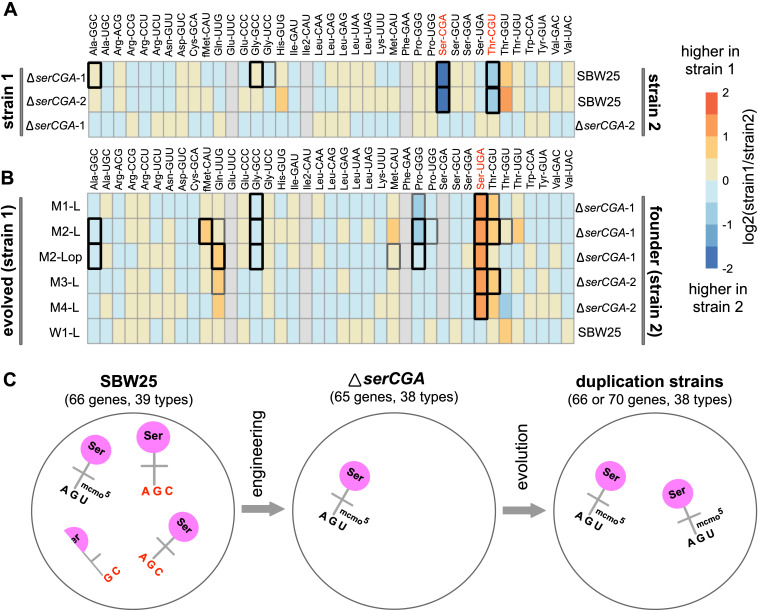
Heatmaps showing differences in mature tRNA levels between strains.The log2-fold.change(strain1/strain2) difference in expression for 36 mature tRNA types (with 38 different primary sequences) was determined for pairs of strains using DESeq2. (A) Mature tRNA expression levels in the serCGA deletion mutants compared with SBW25, demonstrating a consistently lower levels of tRNA-Ser(CGA) and tRNA-Thr(CGU) upon deletion of serCGA. tRNAs in red show a consistent difference in all comparisons except ΔserCGA-1 versus ΔserCGA-2 (row 3), the control comparison for which no significant differences in mature tRNA levels were detected. (B) tRNA-Ser(UGA) is higher in the mature tRNA pool in each of the five serTGA duplication isolates compared with the deletion mutant (with no significant differences detected in the wild type control Line, row 6). Some tRNA types were removed from the DESeq2 analysis (filled grey boxes): Glu-UUC, Ile2-CAU, Phe-GAA, and – in some comparisons – Ser-CGA, consistently gave low read numbers. Box borders represent statistical significance: thin grey = adjusted p>0.01, thick grey = 0.01 > adjusted p>0.001, black = adjusted p<0.001. tRNAs in red show a consistent difference in all comparisons except for the control (row 6). (C) Cartoon depicting the major effects of serCGA deletion (loss of tRNA-Ser(CGA)) and subsequent serTGA duplication (twofold increase of tRNA-Ser(UGA)) on the relative proportions of seryl-tRNAs in the mature tRNA pool.Figure 5—source data 1.This file contains the DESeq2 values from the tRNA expression analysis used in Figure 5 panels A and B, and Figure 5—figure supplement 1.Using the aligned YAMAT-seq read data (Supplementary file 7) as input, DESeq2 output consists of: baseMean1 and baseMean2 (the normalized mean expression level of three replicates of strains 1 and 2); fold.change1 and fold.change2 (fold change calculated by baseMean1/baseMean2 or baseMean2/baseMean1, respectively); log2.fold.change1 (log2 of fold.change1); p-value (calculated by assuming a binomially distributed read coverage analogous to Fisher’s exact test [Robinson and Smyth, 2008; Anders and Huber, 2010; Anders et al., 2015]); padj (p-value adjusted for multiple testing with the Benjamini–Hochberg procedure, which controls for false discovery rate Anders and Huber, 2010; Anders et al., 2015). For each pairwise comparison, rows (tRNA types) are ordered according to increasing padj. Next, all rows with a padj < 0.01 (above the solid black line) were ordered by decreasing log2(fold.change1), and those with a negative log2(fold.change1) value were reordered according to decreasing fold.change2. This puts the tRNA types with statistically significant differences first, with those higher in strain 1 listed at the top (ordered by decreasing size of expression difference; green), followed by those higher in strain 2 (ordered by decreasing expression difference; pink). The first tab contains the comparisons investigating the effect of deleting the serCGA gene (Figure 5A). The second tab contains the comparisons investigating the effect of duplicating the serTGA gene (Figure 5B). The third tab contains the comparisons between the five different duplication strains (Figure 5—figure supplement 1). The fourth tab contains the comparisons between each of the five duplication strains and SBW25.